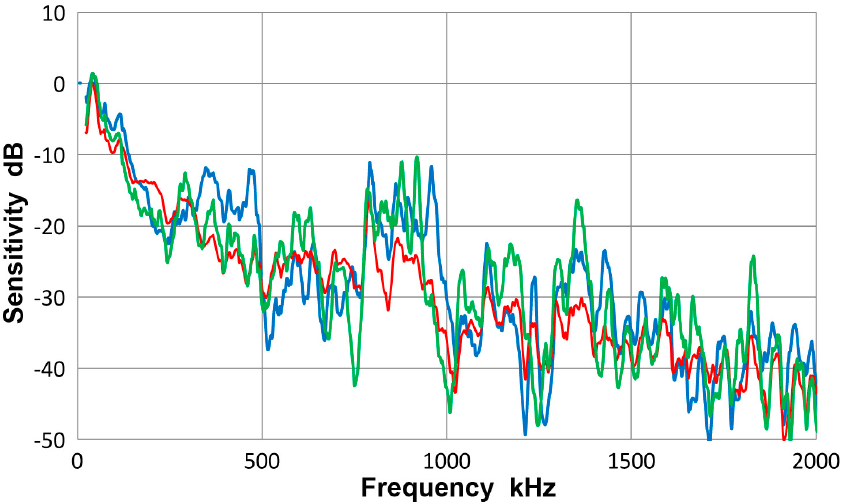
Figure A4. Receiving sensitivity of Olympus V103 transducer. Red -averaged guided wave sensitivity, blue -bar waves from symmetric excitation for 12.7 mm bar, green -bar waves from asymmetric excitation for the same bar.